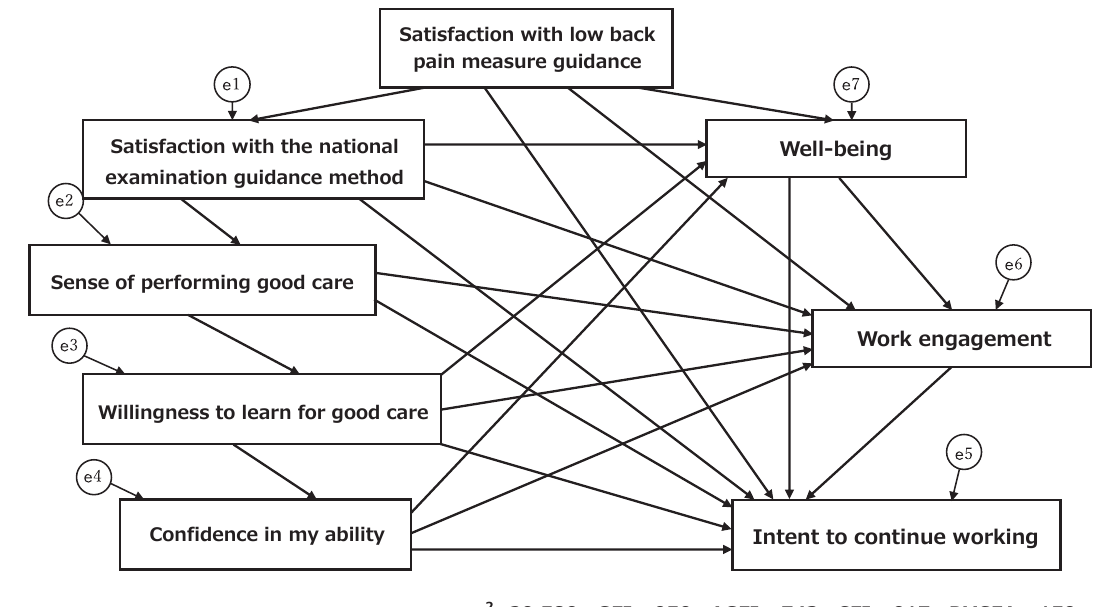
Fig. 1 E ff ect of various factors related to intent to continue working: hypothetical